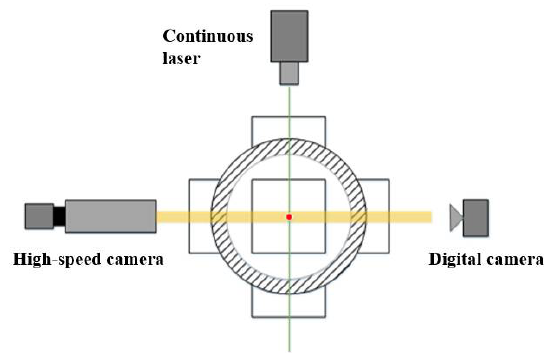
Figure 2. Schematics of the PTIP system.